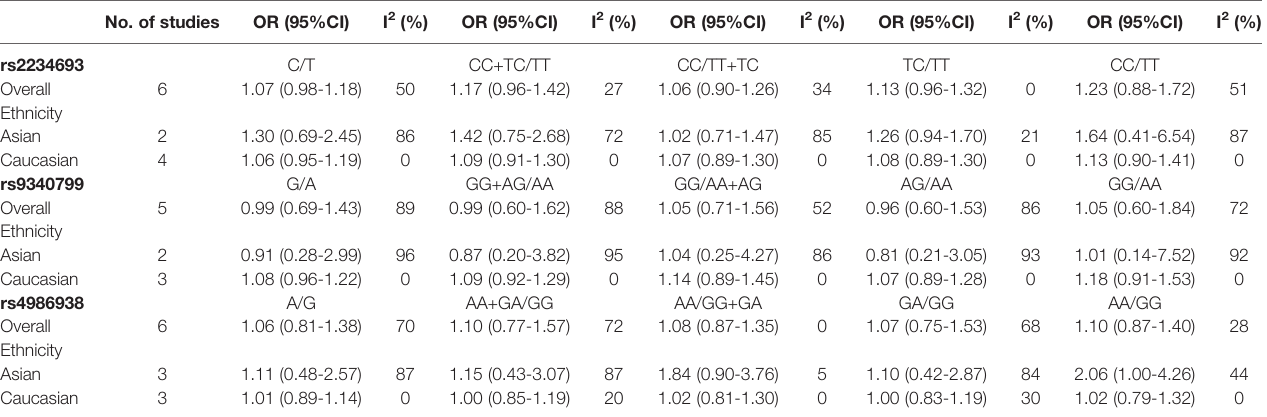
TABLE 3 | Summary ORs in the